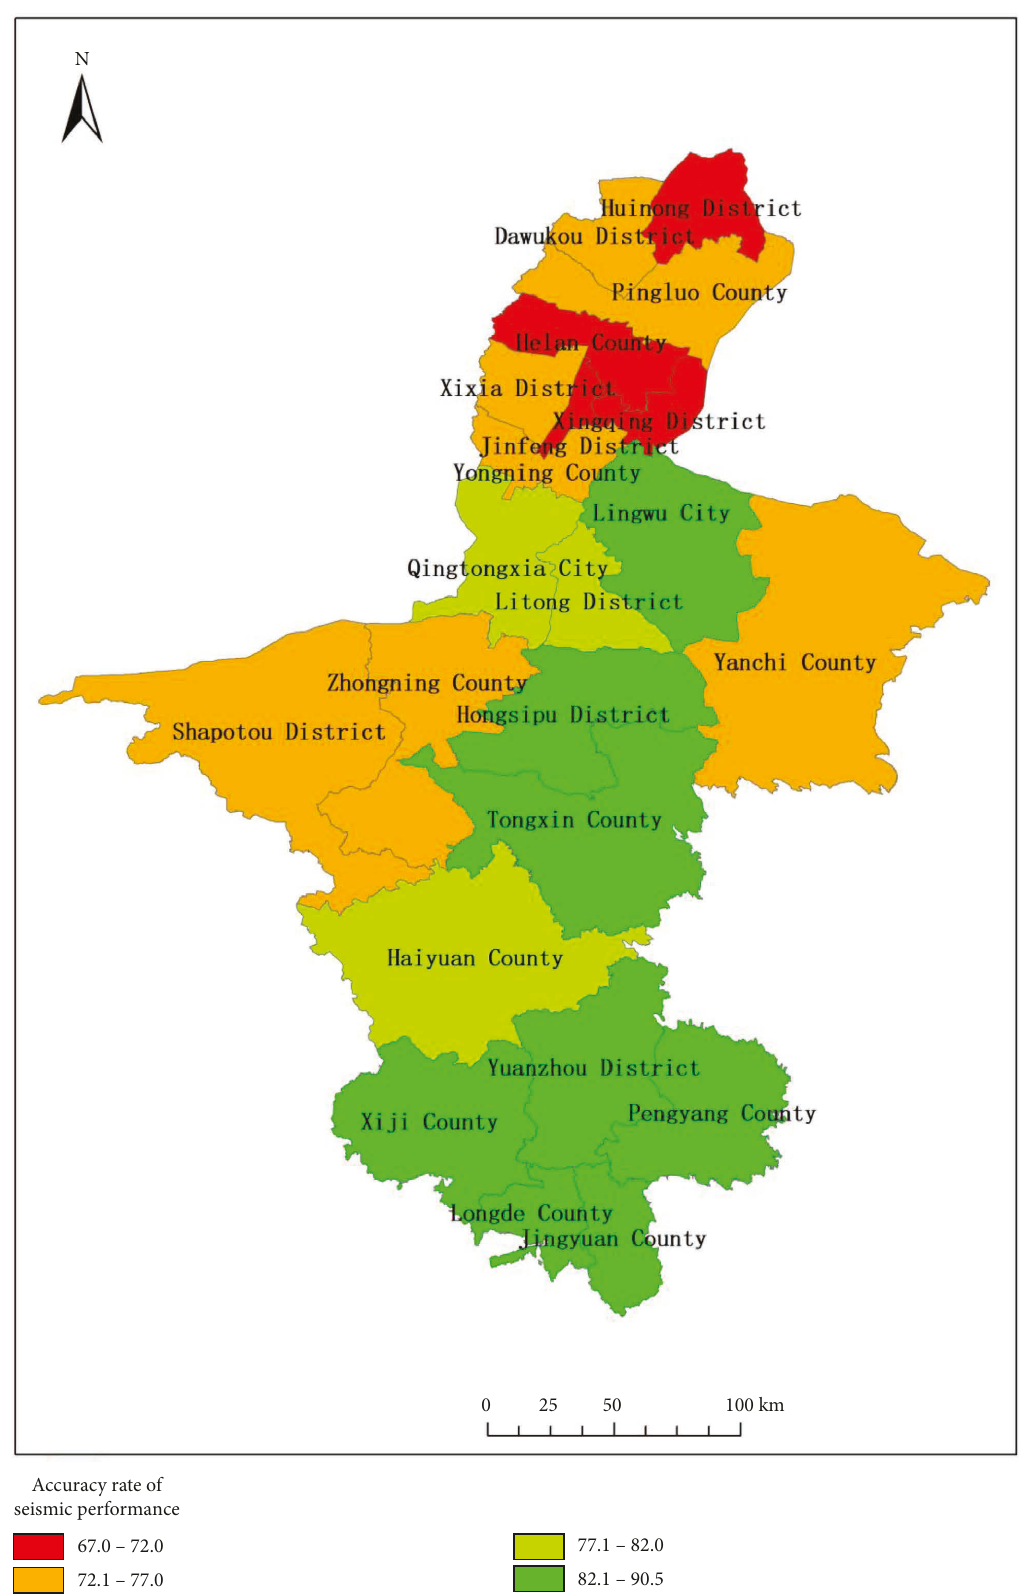
Figure 9: Distribution of the SP accuracy for the buildings across the study